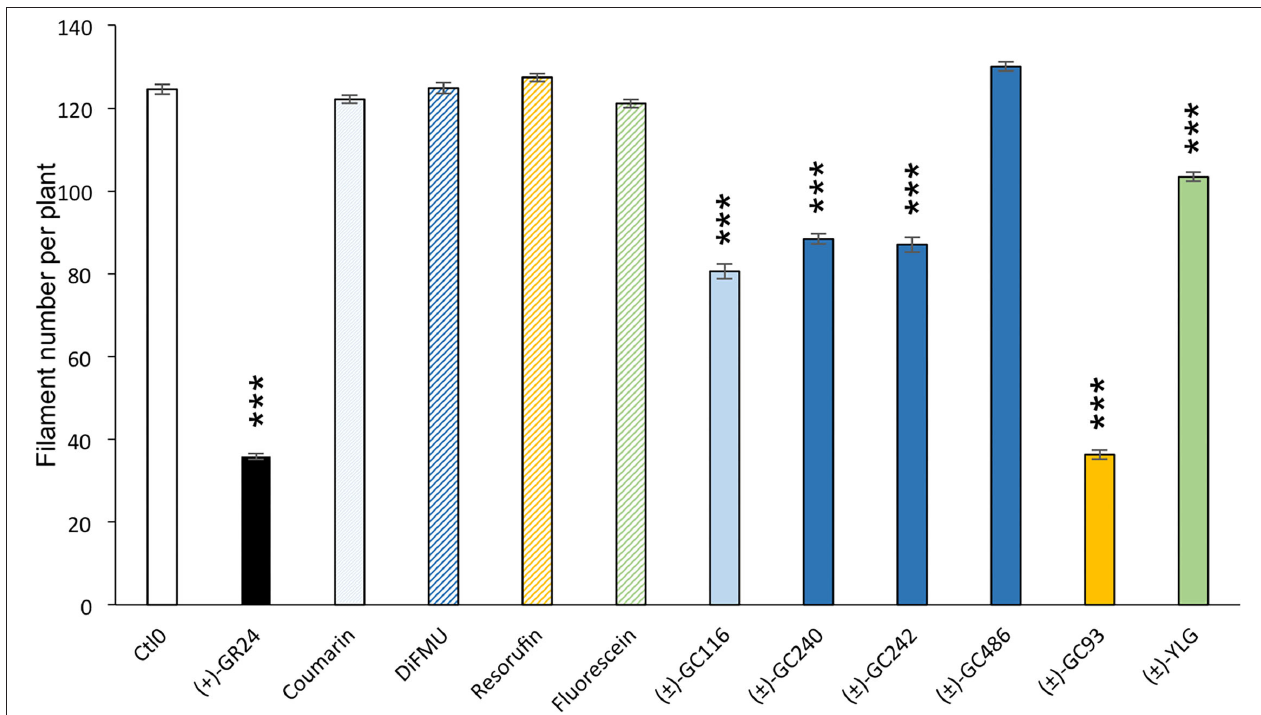
FIGURE 7 | Probe bioactivity tested on the moss P. patens . Bioactivity of fluorophores and profluorescent probes was assayed by counting the number of filaments in the dark following application and was compared to that of DMSO (control 0, white), and ( + )-GR24 (in black). Each compound was used at 1 µ M. Fluorophore bars appear hatched, while the profluorescent probe bars appear plain. Data are mean ± SE of 24 Ppccd8 mutant plants ( n = 24) grown in three different 24-well plates. Significant differences between the control treatment (0nM) and treated plants are based on ANOVA and Tukey’s test as a post-hoc test; *** P < 0.001. CTL0, control